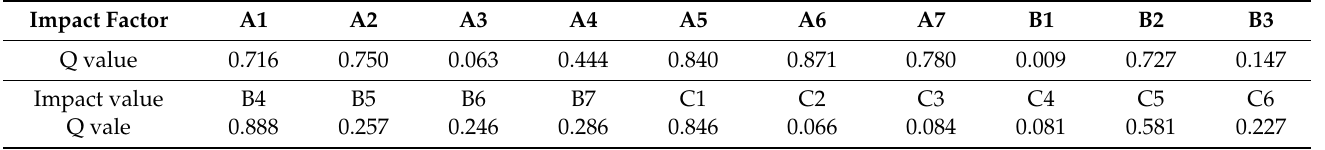
Table 10. Statistical table of driving factors for the socio-ecological vulnerability index in Aba